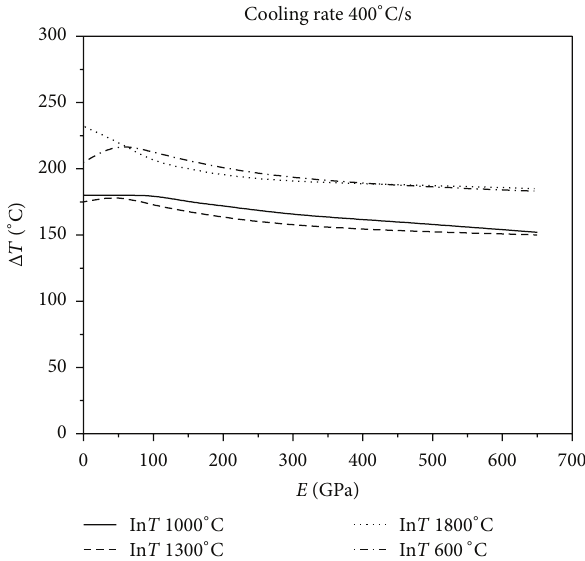
Figure 6: Relationship between critical fracture temperature corre- sponding to different thermal shock initial temperature and Young’s modulus of constraint material under the cooling rate 50 ∘ C/s.